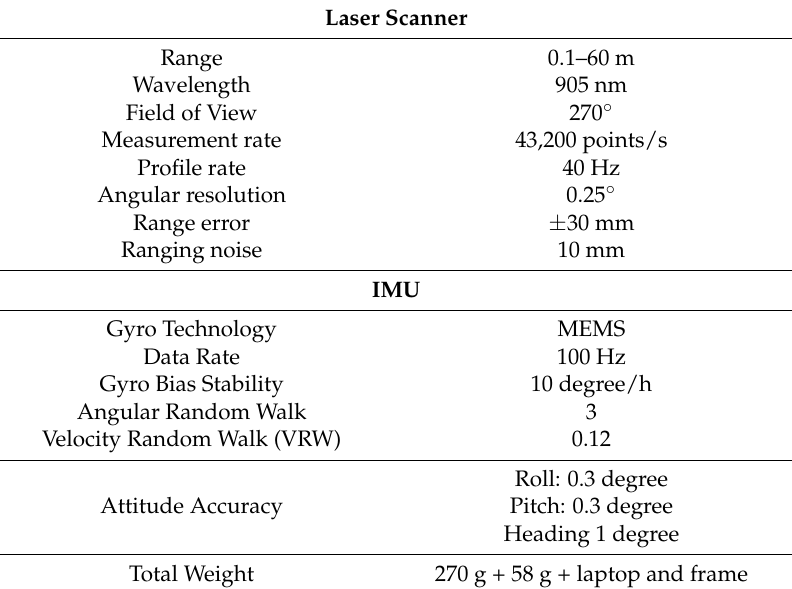
Table 2. Technical Specification of